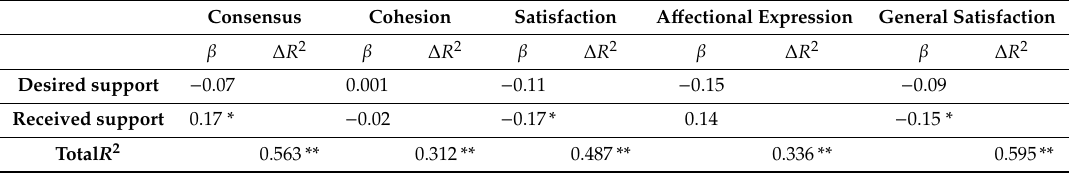
Table 3. Linear hierarchical regression analysis, in which the quality of the partnership and its components were explained variables.